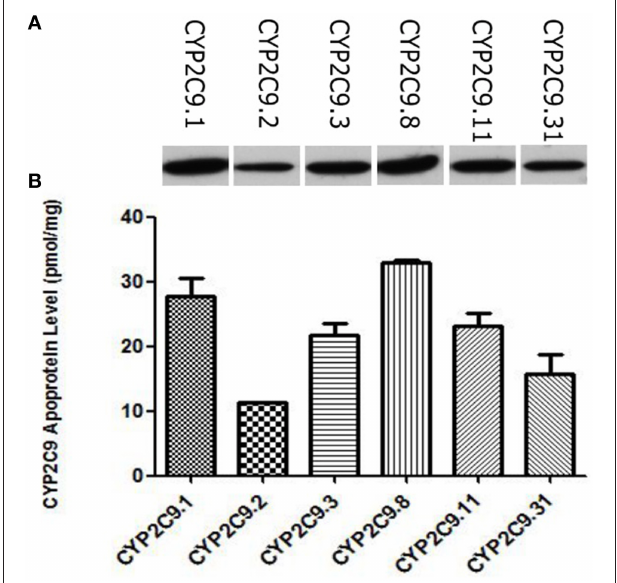
FIGURE 1 | Detection of CYP2C9 proteins by western-blot analysis (A) and the relative expression level of CYP2C9 proteins expressed in COS-7 cells (B). Recombinant CYP2C9s were recognized by rabbit-produced anti-CYP2C9 antibody, and experiments were conducted in triplicate